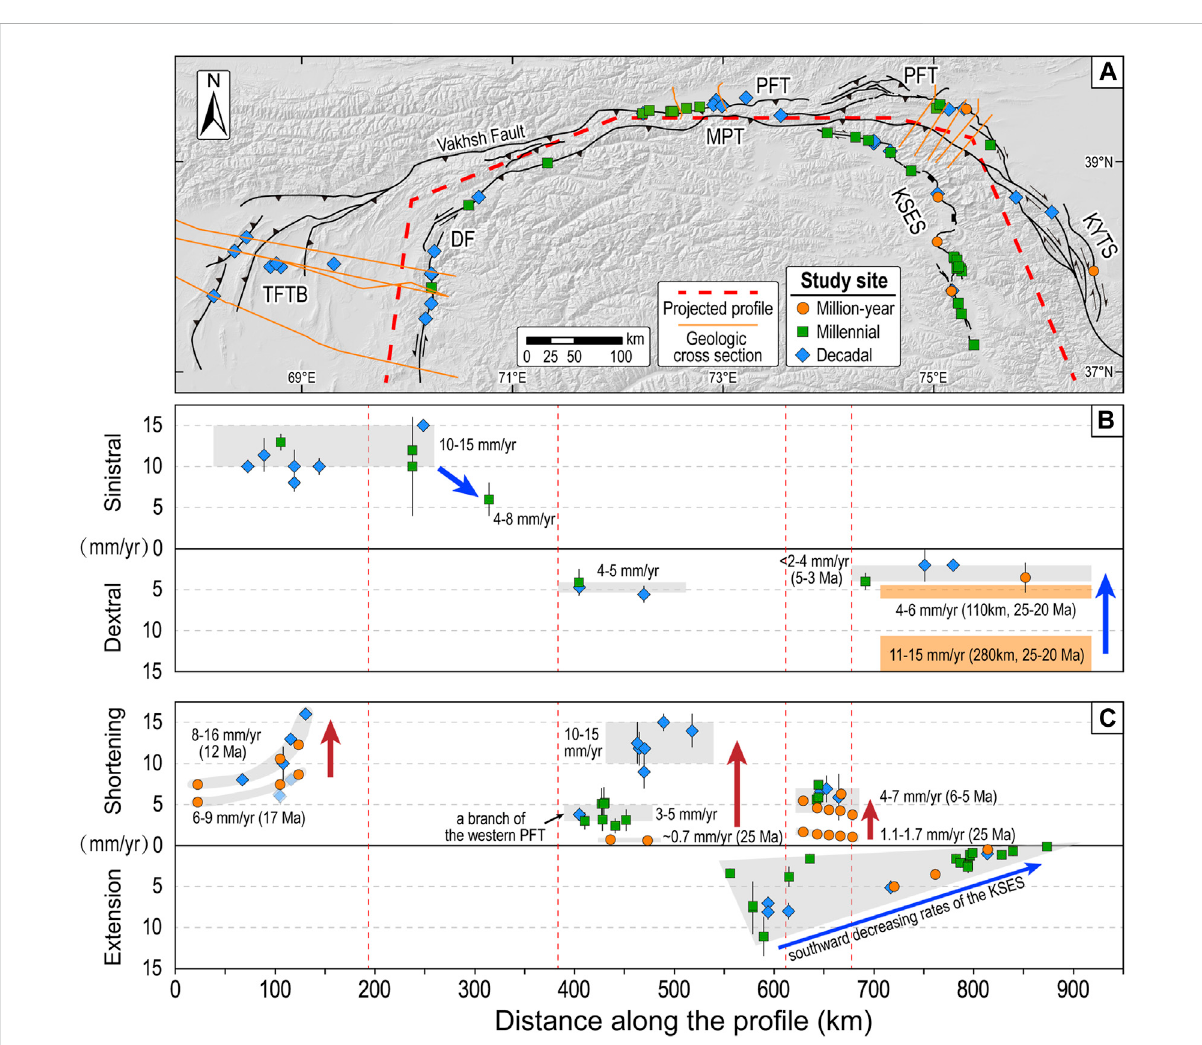
FIGURE 8 Projections of deformation rates at three timescales along the arcuate front of the Pamir salient (modi fi ed from Ge et al. (2022)). (A) Study locations of geologic cross-sections (thin, orange lines) and deformation rates at million-year, millennial and decadal timescales. (B) Deformation rates parallel to the pro fi le denote strike-slip rates. (C) Deformation rates perpendicular to the pro fi le denote shortening and extensional rates. The direction of extension rates is east to west. In Figures (B,C) , the red dotted lines represent the turning points of the projected pro fi le; the grey shadows show approximate ranges or trends of rates; the brownish-red and blue arrows show increasing and decreasing trends of rates across different timescales, respectively. The transparent blue diamonds in Figure C are the underestimated decadal rates of the TFTB. Fault names see Figure